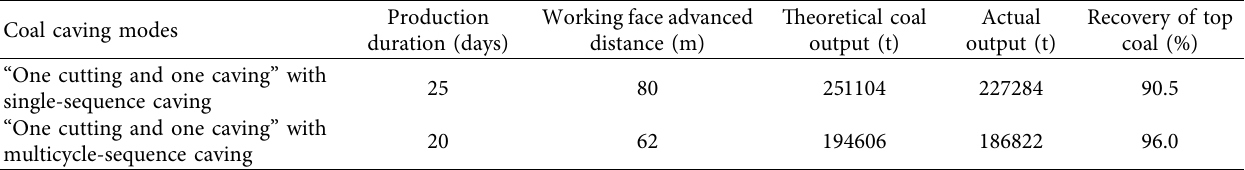
Table 10: Output of the working face from January to February